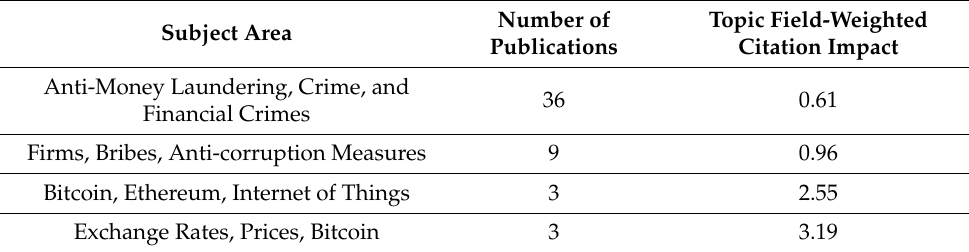
Table 3. Scholarly Contribution of Teichmann, 2017–2021.